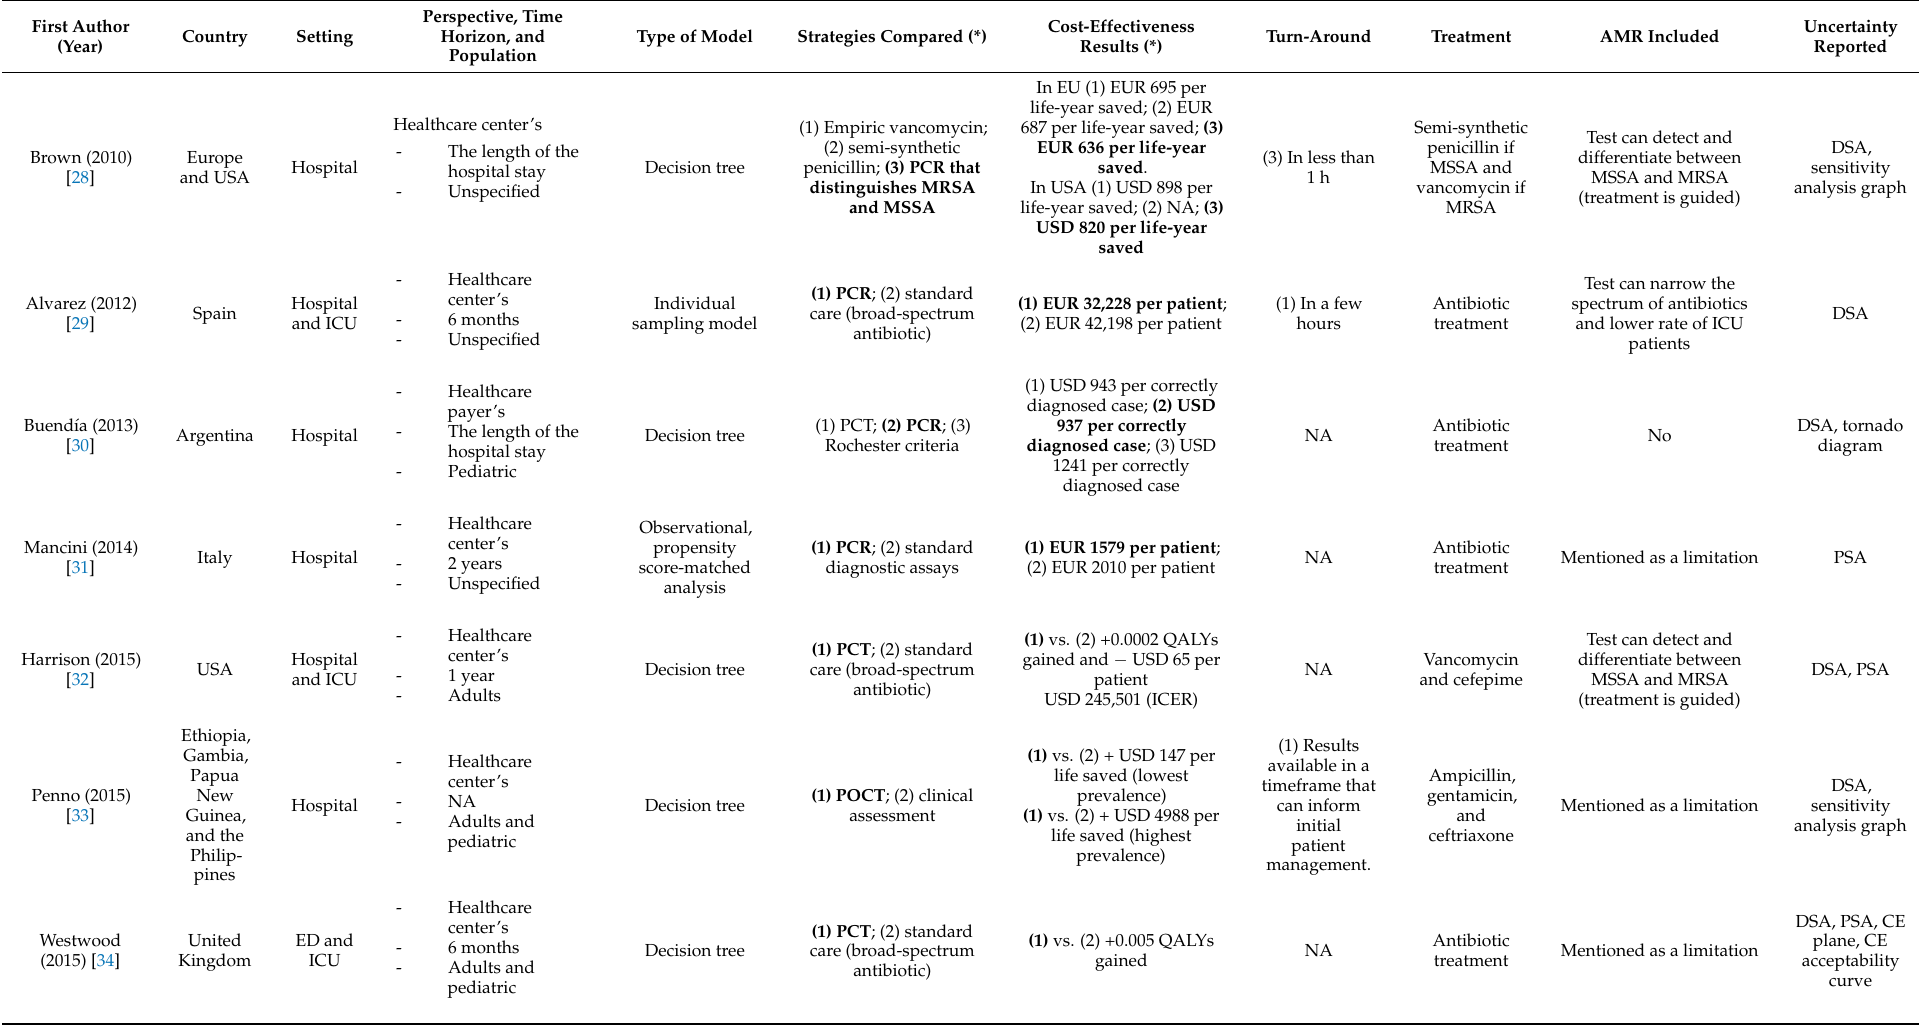
Table 1. Sepsis diagnostic